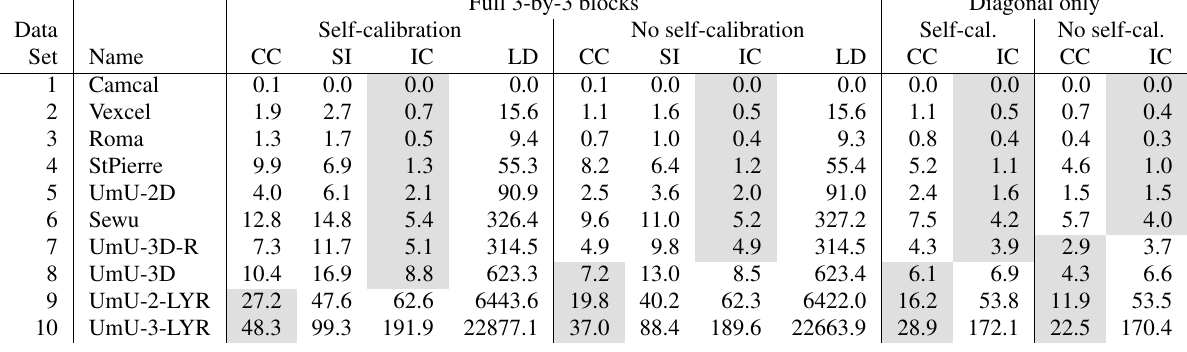
Table 3: Execution times in seconds for the SC, NSC, and TV experiments. The fastest algorithm within each block is highlighted. Overall, the IC algorithm is the fastest for small data sets, whereas the CC algorithm is fastest for large data sets. The SI algorithm has intermediate performance. The cross-over point depends on the requested computation and whether the data set is a self- calibration data set or not. The IC algorithm is faster than the legacy LD algorithm by 1–2 orders of